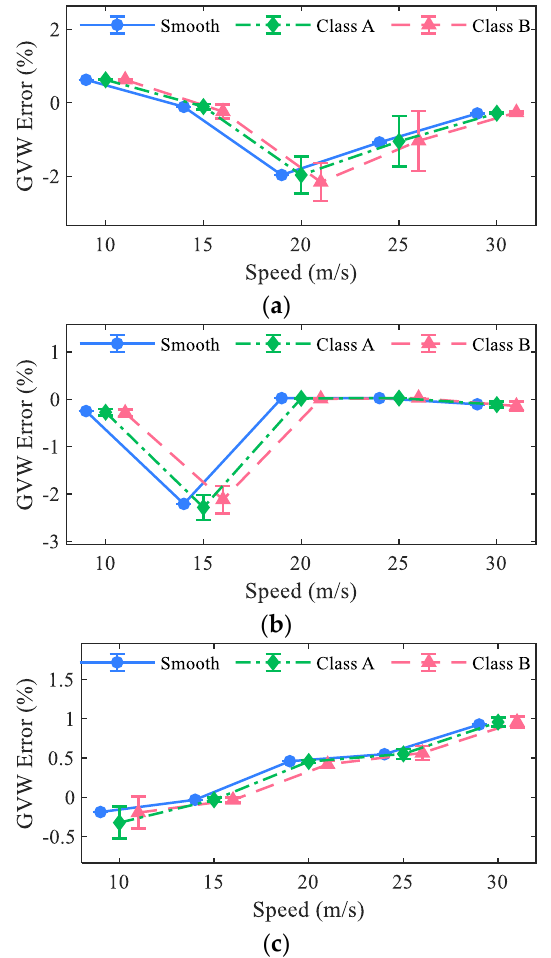
Figure 11. Identified gross weight error: ( a ) 2-axle truck, ( b ) 3-axle truck, and ( c ) 5-axle truck.